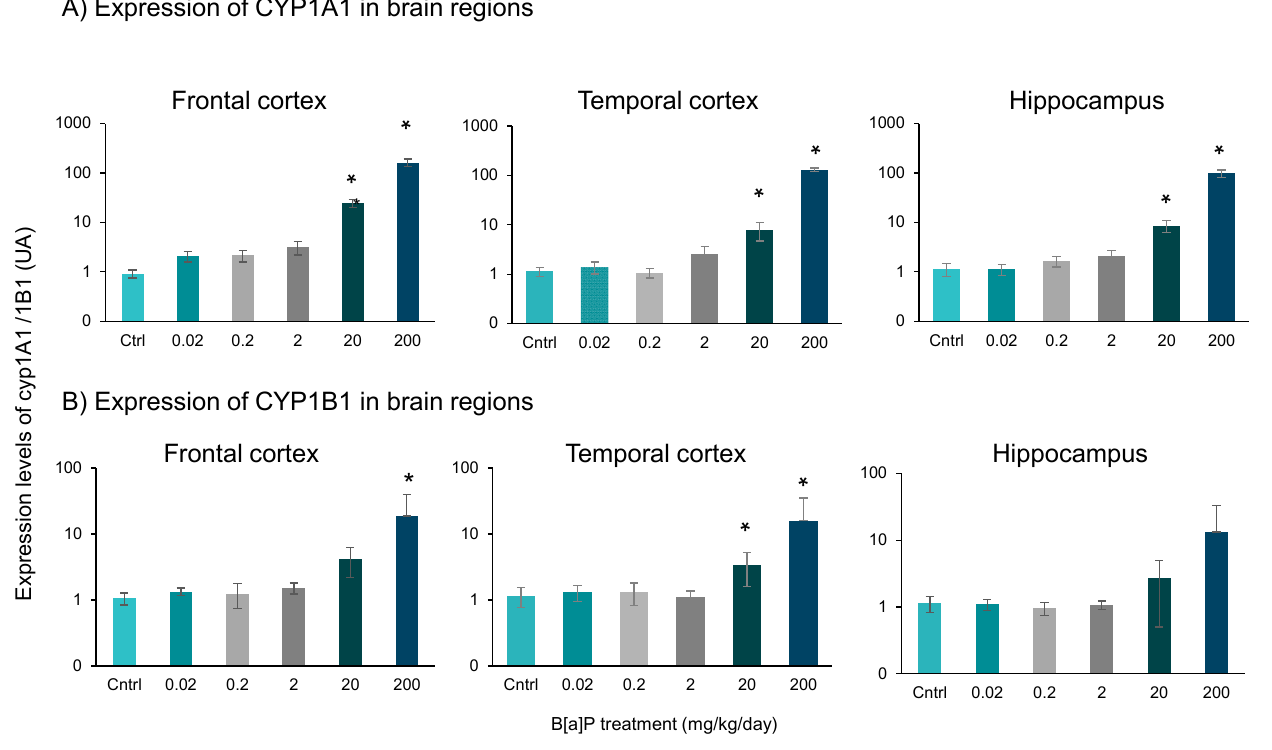
Figure 4. Levels of mRNA expression of Cyp1a1 ( A ) and Cyp1b1 ( B ) genes in brain regions (temporal and frontal cortex and hippocampus) in B[a]P-exposed mice via oral administration at doses ranging from 0.02 to 200 mg/kg for 11 consecutive days. Results were reported as average +/- SEM of 10 mice. * p < 0.05 vs. controls (SNK-t test for multiple comparisons).